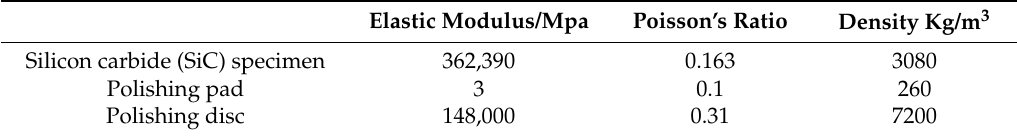
Table 1. Material parameters of